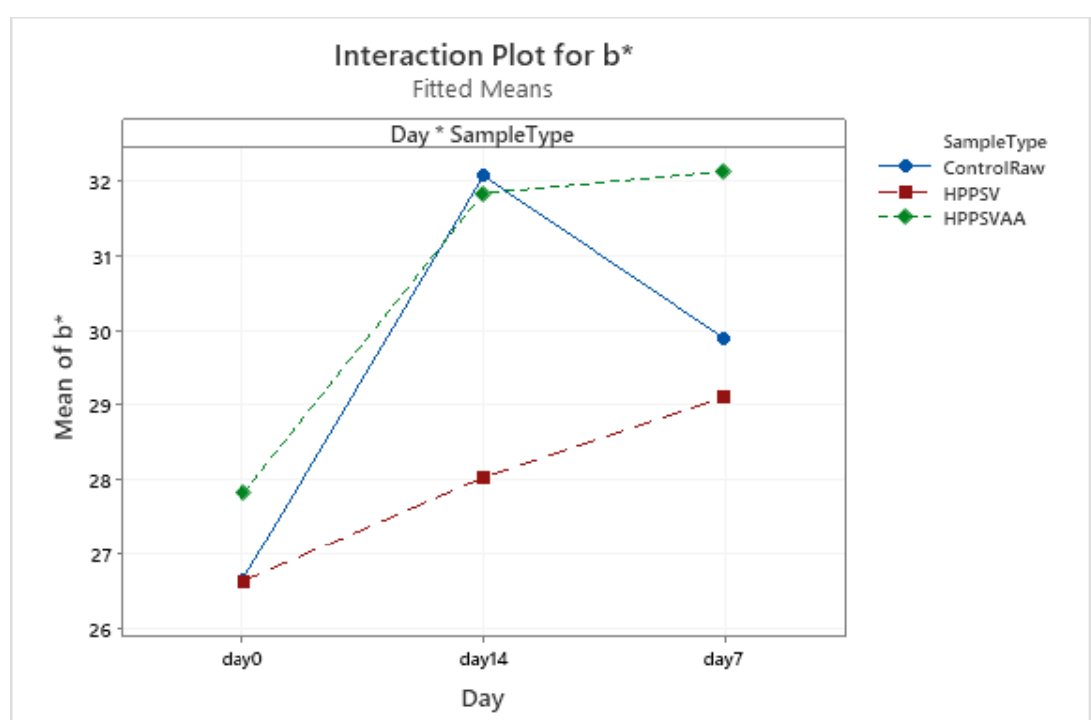
Figure A17 . Effect of treatments and storage time on the a* coordinate of plant-based patty (HPPSV: HPP-SVCOOK).